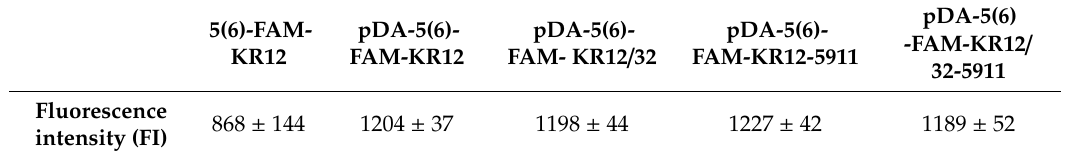
Figure 4. Fluorescence microscopy images of the Ti6Al4V surface coated for 24 h with 5(6)-FAM-labelled ( a ) KR12, ( b ) pDA-KR12, ( c ) pDA-KR12/32, ( d ) pDA-KR12-5911, and ( e ) pDA-KR12/32-5911; and ( f ) for Ti6Al4V without coating. Table 5. Fluorescent intensity values of various Ti6Al4V peptide-coated surfaces over 24 h.